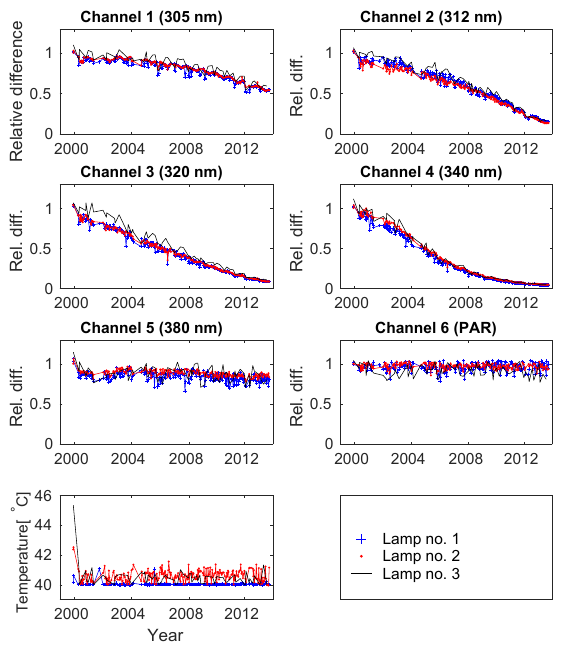
Figure 2. The same as Fig. 1 but for